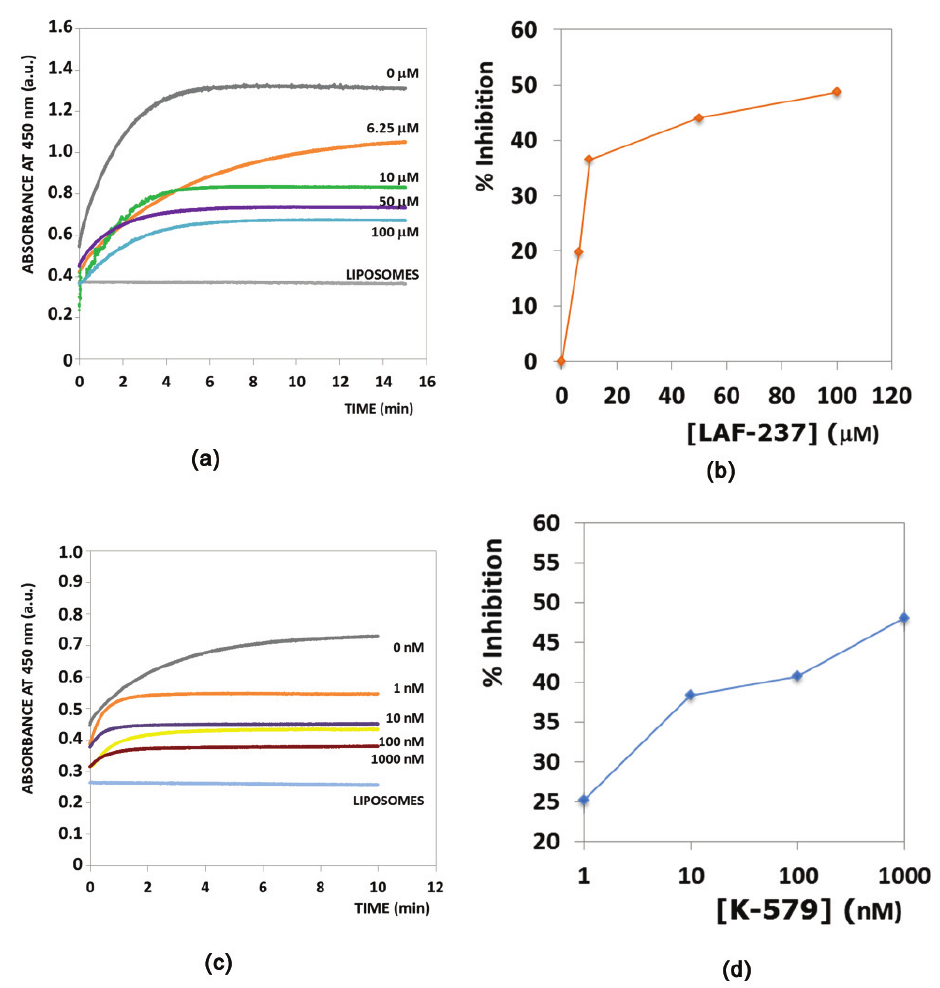
Figure 2. PI-PLC inhibition using DPP4 inhibitors. ( a , c ) Time courses of enzyme activity in the presence of varying amounts of inhibitors, respectively LAF-237 and K579. The trace marked LIPOSOMES corresponds to a control in the absence of PI-PLC. ( b , d ) Dose-response effect of inhibitors on PI-PLC activity. Activity was computed as the extent of vesicle aggregation after 10 min enzyme